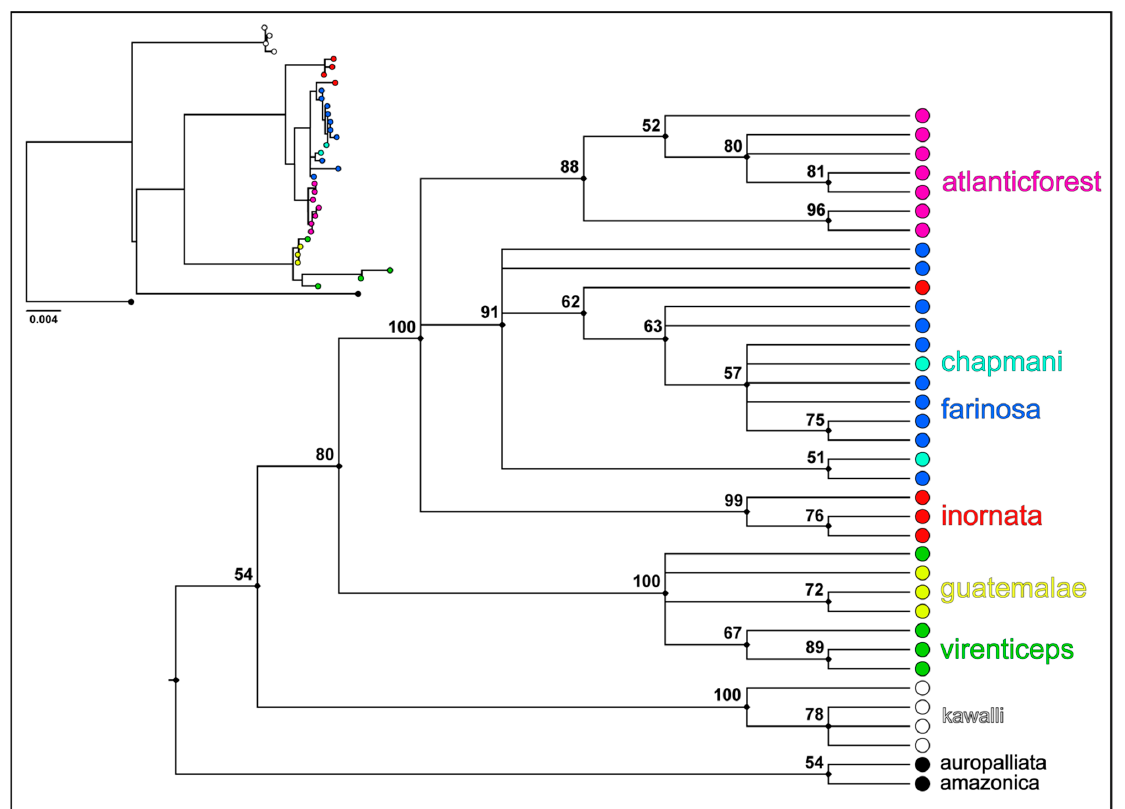
Figure 2. Maximum likelihood majority rule consensus tree (cladogram) and median joining haplotype networks. Maximum likelihood majority rule consensus tree based on an analysis of the combined nuclear and mtDNA from all northern and southern mealy amazon clades. Numbers to the left of each node are bootstrap consensus values. The insert to the left of the consensus tree is a phylogram of the best tree recovered from the same maximum likelihood search and illustrates the deep split in the evolutionary timeline of the northern and southern species, as well as the relatively shallow split between the Atlantic Forest clade and the other southern mealy amazon clades. The relative branch lengths of the phylogram represent sequence